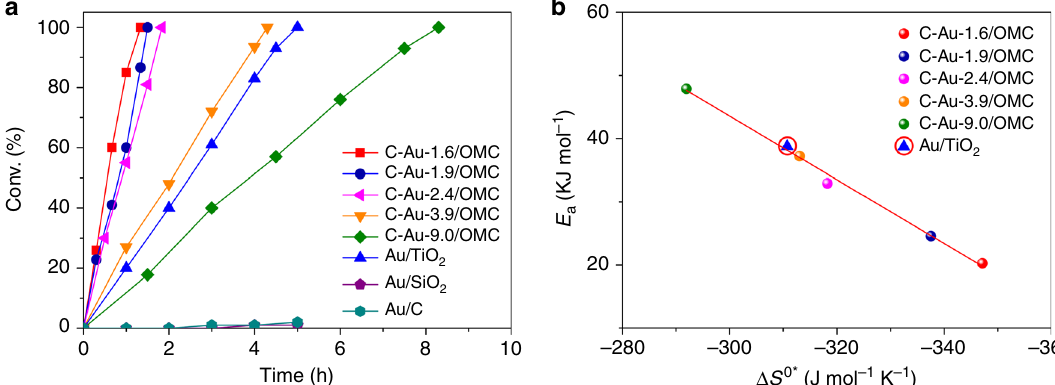
Fig. 3 Kinetics analysis. a 3-NS conversion as a function of time with the following reaction conditions over C – Au nanoparticles of different sizes supported on ordered mesoporous carbon. The reaction conditions were: 0.78 μ mol of Au; 0.41 mmol of substrate; 5 mL of ethanol; 140 °C; 4.0 MPa H 2 . b Relationship between the activation energy ( E a ) and entropy of activation ( Δ S 0 *) for the hydrogenation of 3-NS to 3-VA. For comparison, the results over commercial Au/TiO 2 , Au/SiO 2 , and Au/C are also